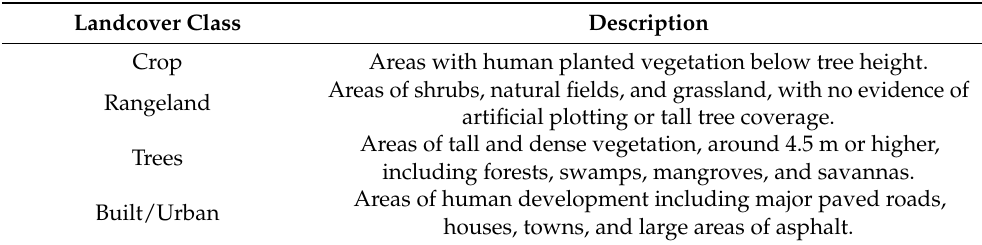
Table 2. The four types of landcover analysed for their association with LF infection markers in American Samoa. Data were taken from the recently updated Esri Land Use/Land Cover 10 m map [43]. Landcover Class Description Crop Areas with human planted vegetation below tree height. Areas of shrubs, natural fields, and grassland, with no evidence of Rangeland artificial plotting or tall tree coverage. Areas of tall and dense vegetation, around 4.5 m or higher, Trees including forests, swamps, mangroves, and savannas. Areas of human development including major paved roads, Built/Urban houses, towns, and large areas of